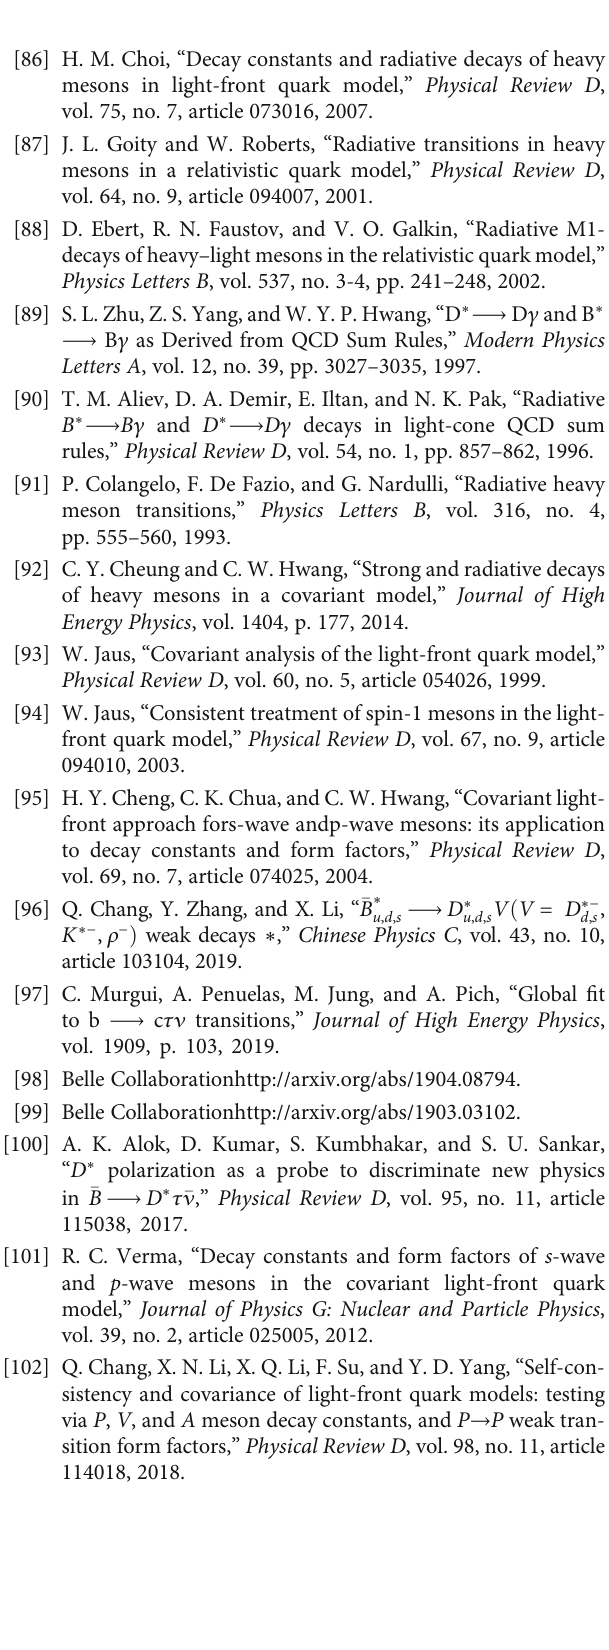
e ff ects of the vector leptoquark on The European Physical Journal C , vol. 79, no. 2,